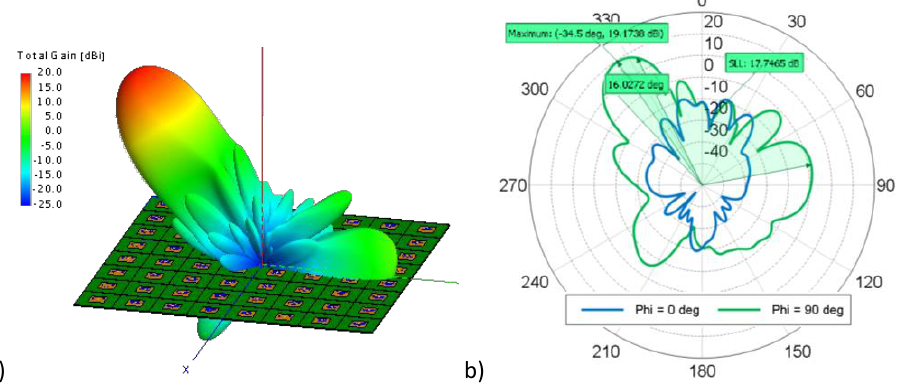
Fig. 8. The antenna array 3D (a) and polar (b) radiation pattern at beam angle of 35 degrees.